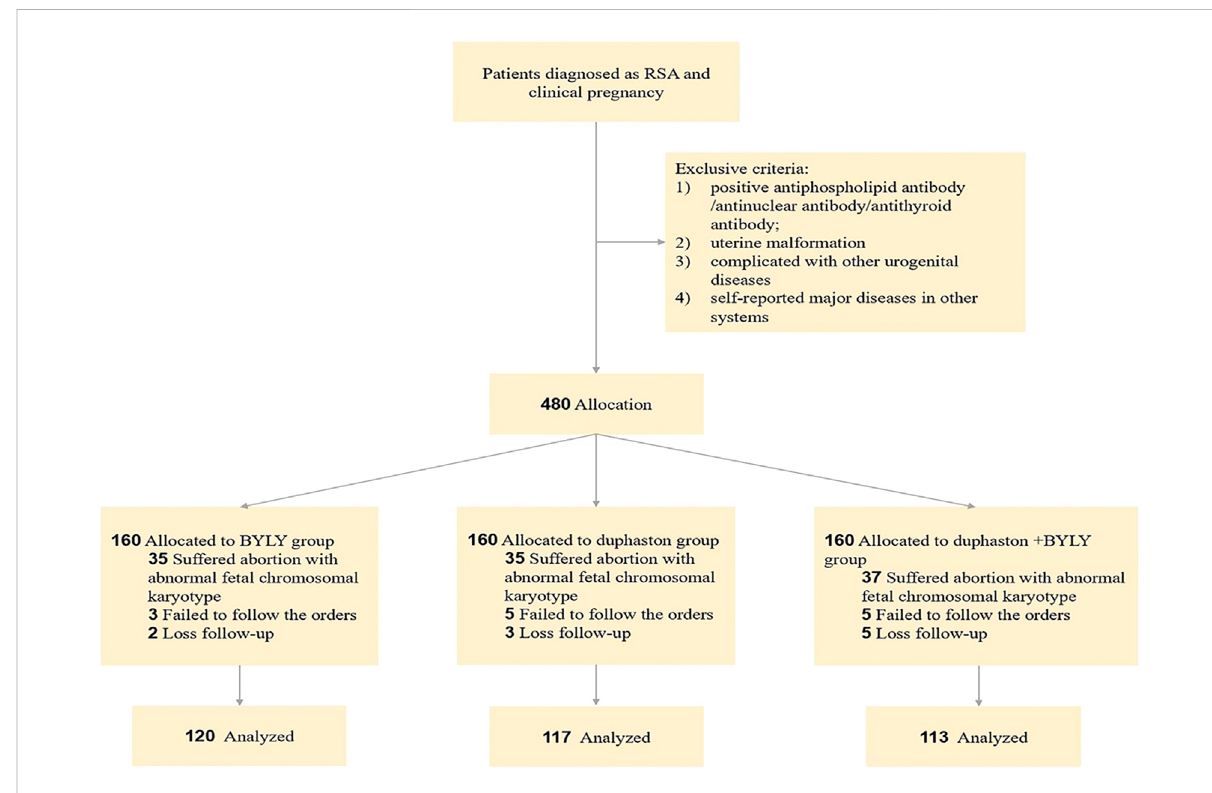
FIGURE 1 Flowchart of study on BYLY for patient with RSA. Abbreviation: BYLY, Bushen Yiqi Lixue Yangtai compounds; RSA, recurrent spontaneous abortion.